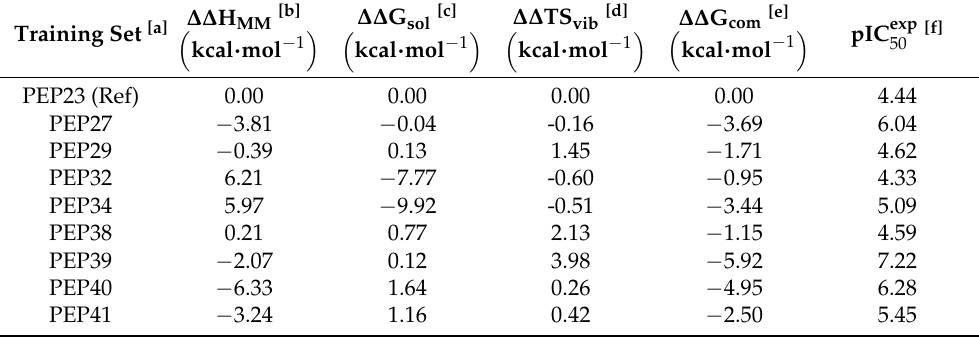
Figure 1. Chemical structures of training and validation sets of FP3 inhibitors obtained from literature [24]. Table 2. Energy contributions towards ∆∆ G com for a dataset of PEP analogues against FP3 complexa- tion Gibbs free energy and its components for the training and validation set of FP3 inhibitors. and experimental